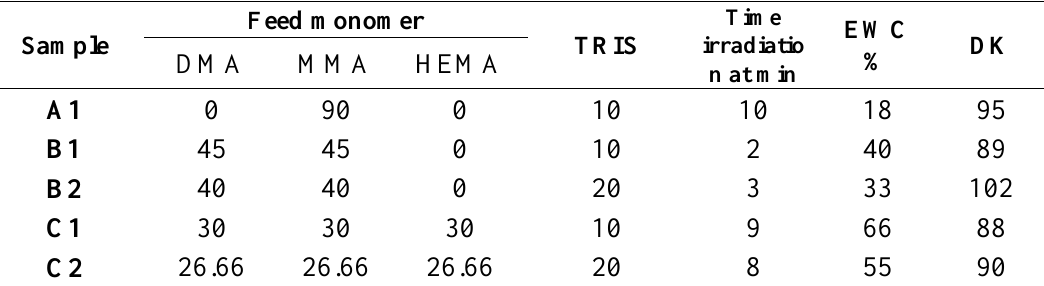
Table.1. Formulations of silicone hydrogel through copolymerization of TRIS, DMA, MMA,